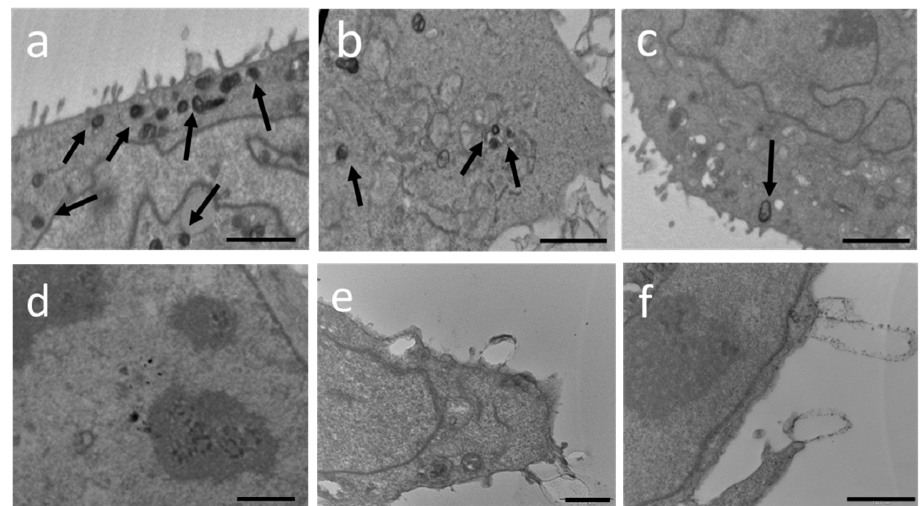
Figure 7. Transmission electron micrographs of keratinocytes incubated with TET 0.9 -DMF ( a – c ) or TET 2.7 -DMF ( d – f ) for 2 h ( a , d ), 6 h ( b , e ), and 24 h ( c , f ). Bars: 1000 nm ( a ), 2000 nm ( b , c ), 3000 nm ( d ), and 1000 nm ( e , f ).